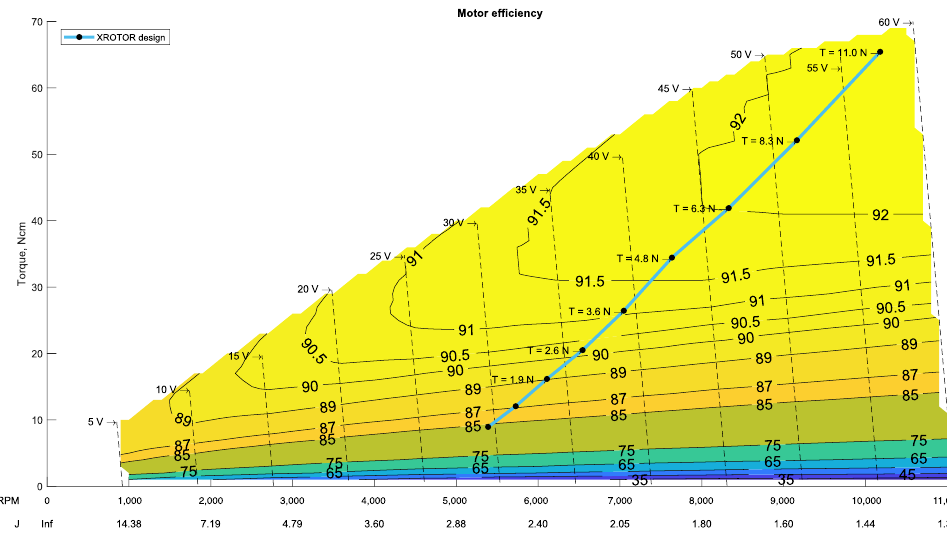
Figure 7. Lehner 2280/40 motor map: torque vs. RPM, contour of motor